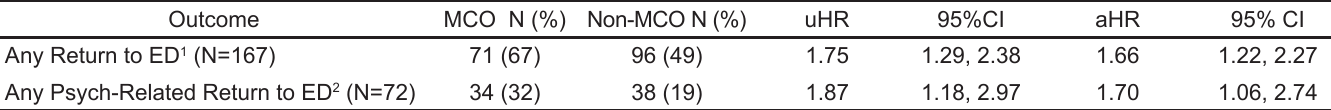
1 Adjusted for indicator of family support. 2 Adjusted for schizophrenia, bed request at index visit, and previous visit for suicidal ideation. MCO , mobile crisis outreach; uHR : unadjusted odds ratio; aHR , adjusted hazard ratio; N , number of patients; CI , confidence interval; ED , emergency department.